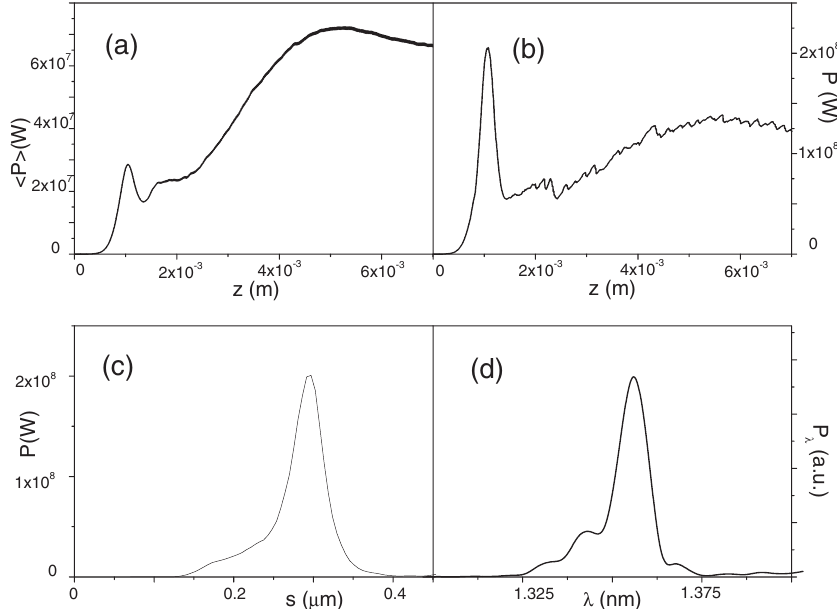
FIG. 10. (a) average power P (W) vs the coordinate along the undulator z (m); (b) peak power along z ; (c) power profile along the bunch coordinate s ( (cid:4) m ) at z (cid:6) 2 : 5 mm ; (d) power spectrum at z (cid:6) 2 : 5 mm .